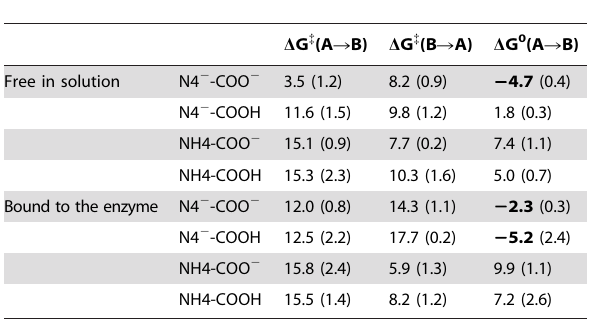
Table 3. Energetics of the rotation of the hydroxyethyl group of hydrolyzed biapenem in solution and in the enzyme (Configuration No. 4 in Table 1 and Fig. 6A